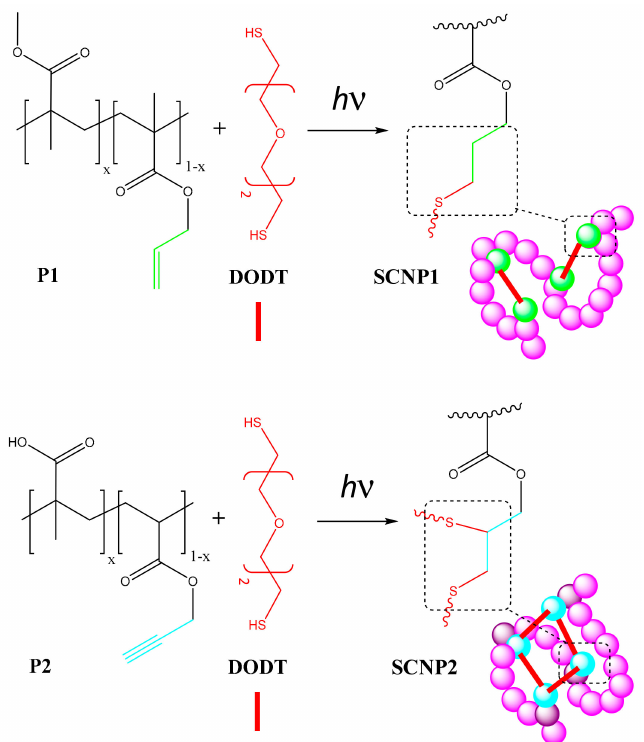
Figure 15. Synthesis of SCNPs via photoactivated radical-mediated thiol-ene / thiol-yne coupling using 3,6-dioxa-1,8-octane-dithiol (DODT) as a homobifunctional cross-linker (in red color ) and copolymers P1 and P2 as precursors decorated with alkene (in green color ) and alkyne (in blue color ) pendants, respectively. Reprinted from [52] with